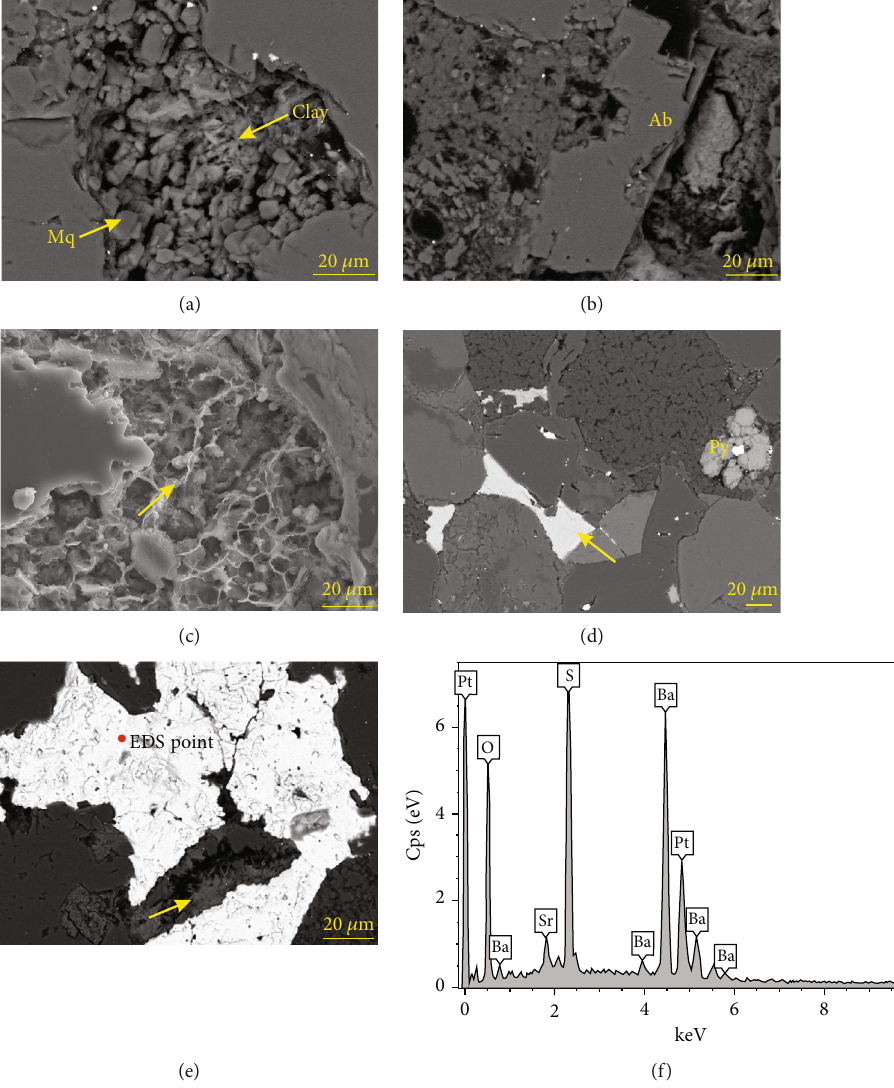
Figure 5: SEM-BSE images of beach-bar sandstones in the Boxing Sag. (a) F1, 3314.6m: authigenic microquartz (Mq) and a few clay minerals; (b) F1, 3314.6m: authigenic albite (Ab); (c) G351, 2455 m: the feldspar dissolution is accompanied by the precipitation of illite (yellow arrow); (d) G351, 2455m: barite (yellow arrow) and pyrite (Py) are fi lled among particles; (e) F1, 3314.6m: the leached detrital grain associated with chlorite (yellow arrow), and red spot represents an EDS analyzing point; (f) EDS-tested composition of the barite (BaSO 4